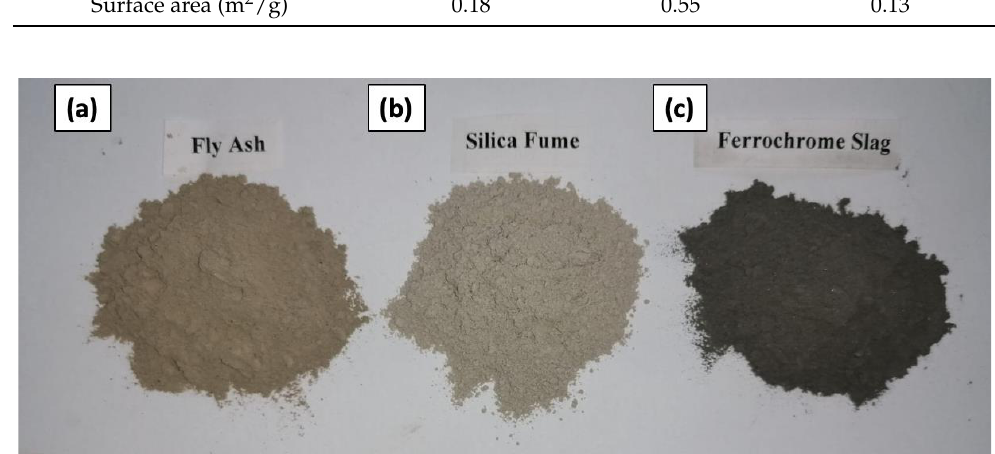
Figure 2. Digital image of ( a ) FA, ( b ) SF, and ( c ) FS.